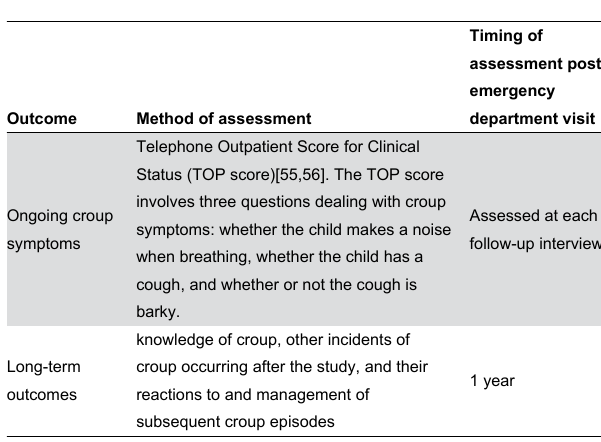
Table 1. Secondary